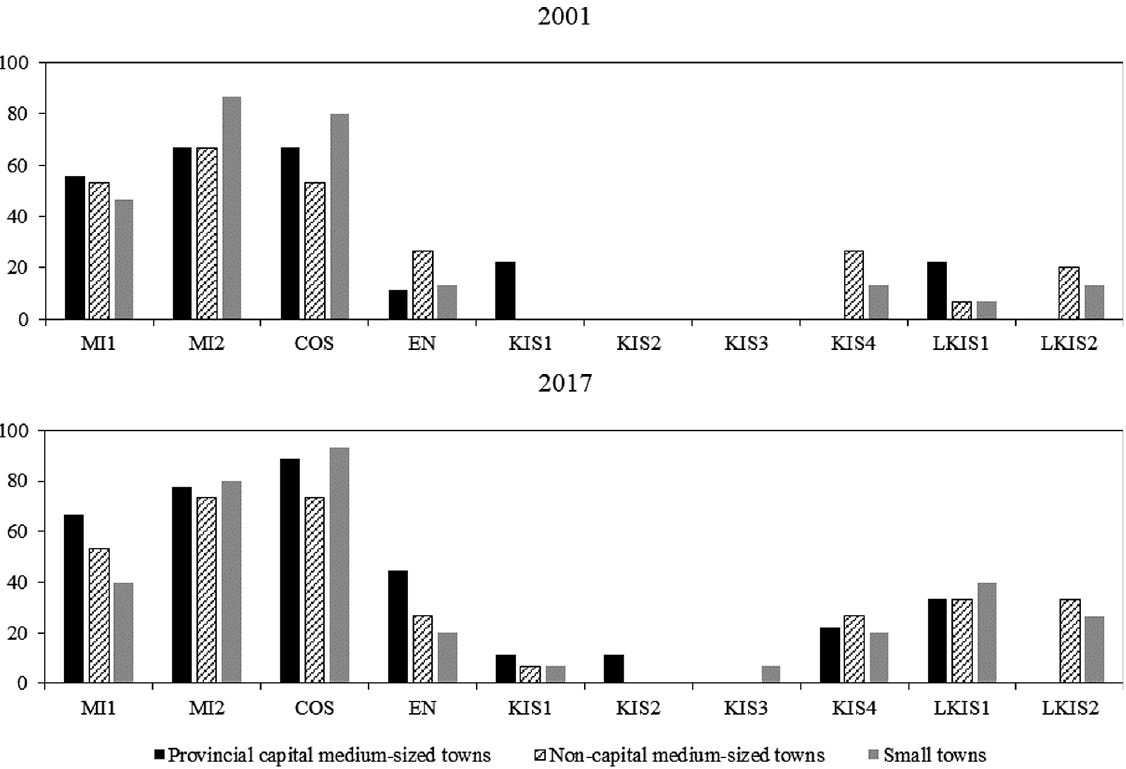
Fig. 4. Specialisation in the local surroundings (LQ>1) in 10 industries broken down by level of technological and knowledge intensity (2001, 2017), percentage